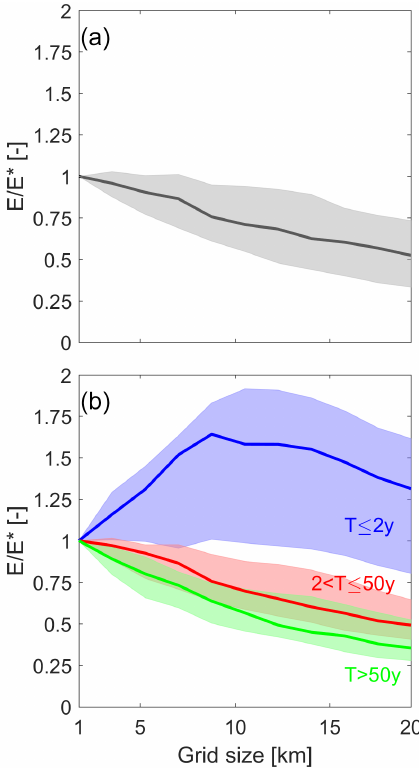
Figure 2. Relative error in the rainfall estimates as a function of the aggregation scale for (a) all the 99 considered debris flow events, and (b) different classes of severity (return period of the 1km grid size triggering rainfall). Solid lines show median values and shaded areas the interquartile